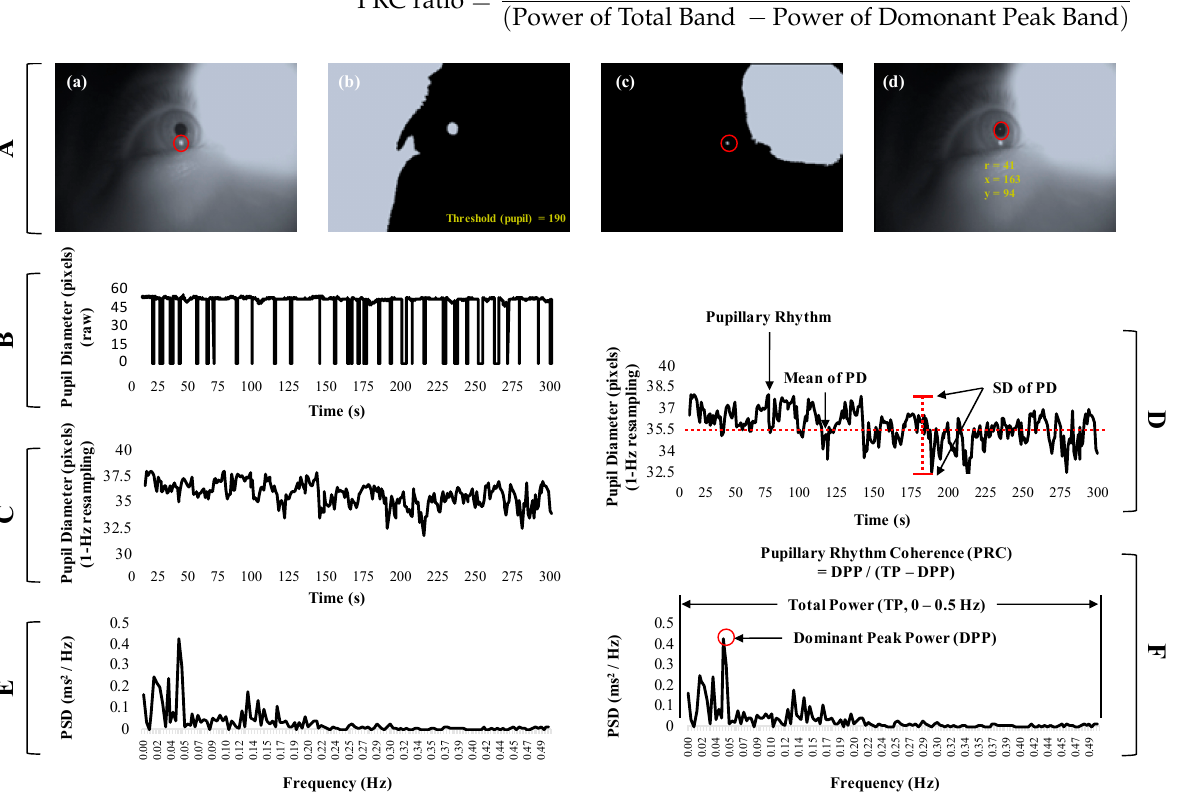
Figure 2. Signal processing for detecting motion sickness from the pupillary rhythm. ( A ) Procedure to detect the pupil area: ( a ) a raw image (gray scale) from the IR camera; ( b ) the binarization image based on the auto threshold; ( c ) detection of the reflected light caused by the infrared lamp; ( d ) detection of the pupil area using the CDE algorithm. ( B ) Pupil diameter signals at 30 fps. ( C ) Resampled pupil diameter (pupillary rhythm) at 1 Hz based on the sliding movement average (window size: 30 fps and resolution: 30 fps). ( D ) Definition for mean and standard deviation (SD) of pupil diameter. ( E ) Spectral signals of pupillary rhythm using the fast Fourier transform (FFT) analysis. ( F ) Definition for pupillary rhythm coherence (PRC).